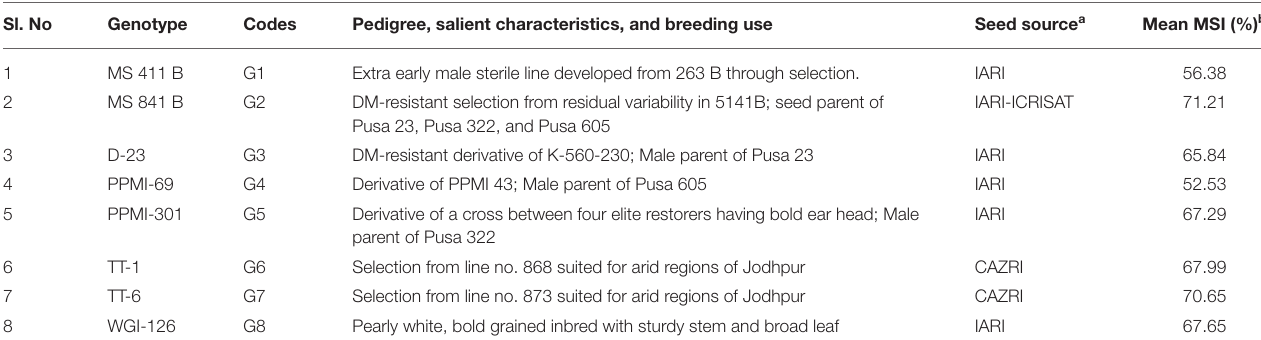
TABLE 1 | Details of genotypes used for transcript expression studies for heat tolerance in pearl millet. Sl.